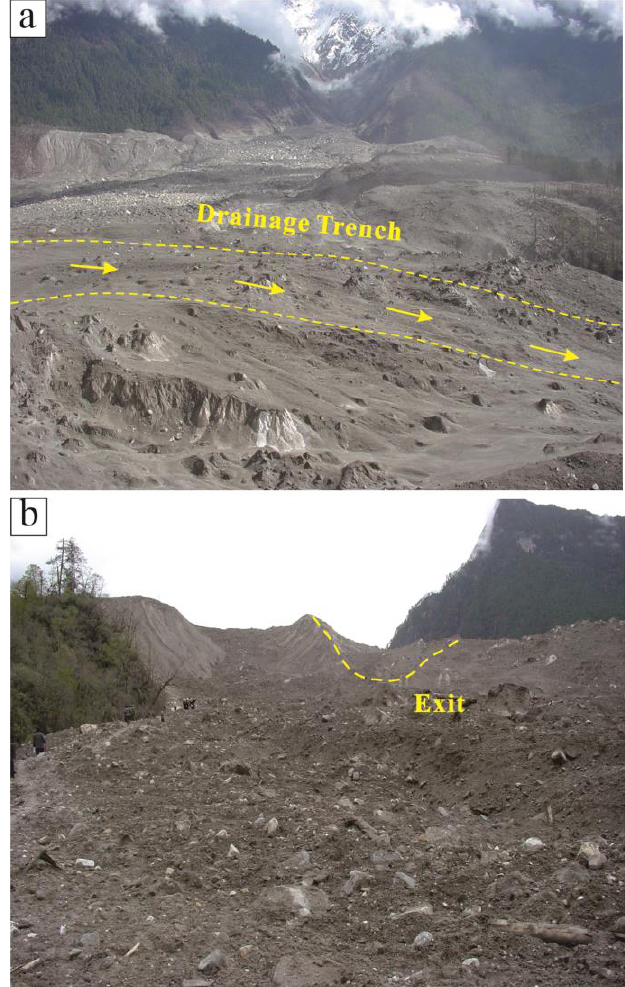
Figure 13. The drainage trench in 2000 Yigong landslide. ( a ) the route of the drainage trench in the accumulation area after the 2000 Yigong Landslide; ( b ) the exit of the drainage trench over the dam body.